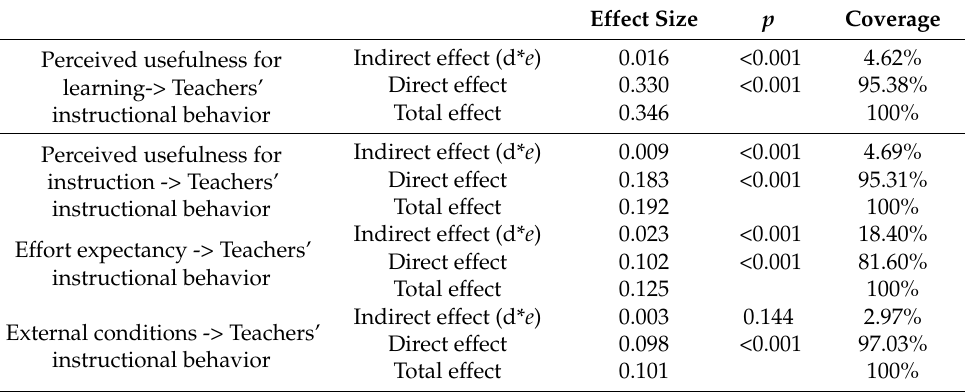
Table 4. The mediating chain analysis of the relationship between predictive variables and teachers’ instructional